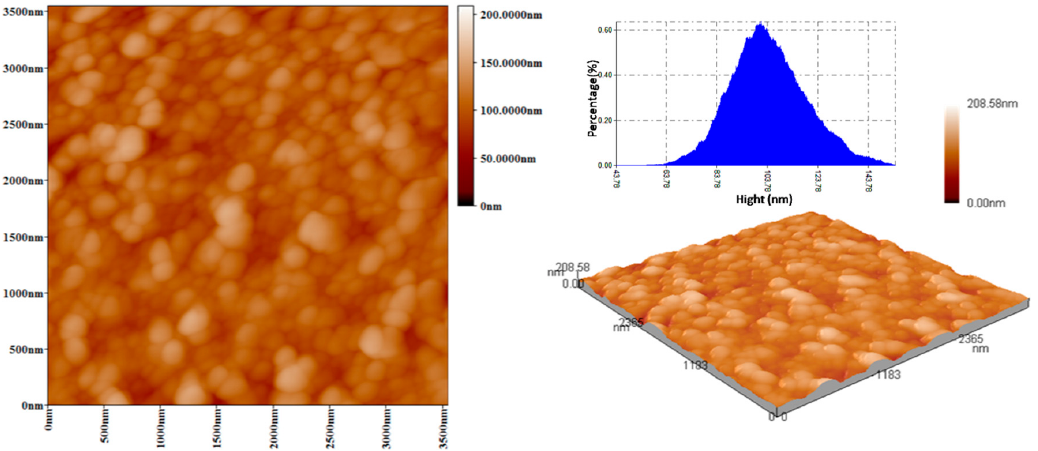
Figure 3. Typical AFM images and its height analysis of LCHBPNIPAM self-assemblies (0.2 mg/mL) at 20 °C.